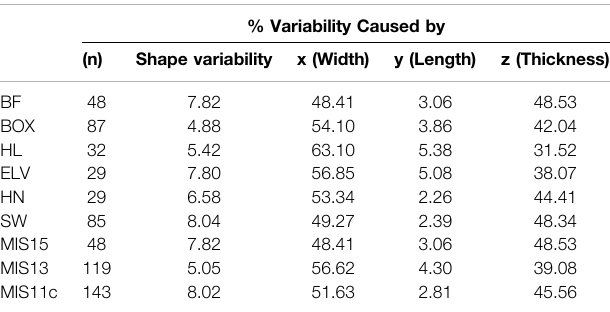
TABLE 3 | Intra-assemblage shape variability analysis (mean multidimensional Euclidean distance of all artefacts from its centroid) and distribution of relative shape variability across dimensions of Figure 2